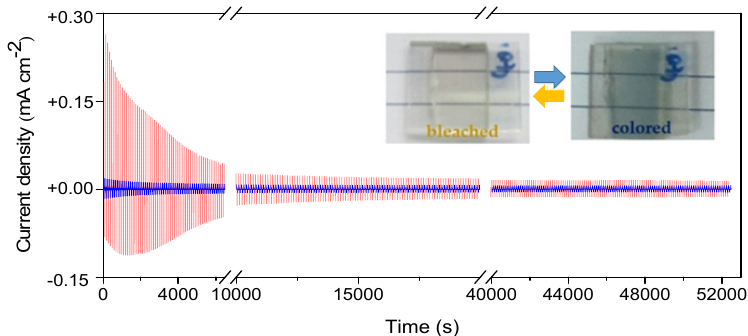
Figure 6. Current density as a function of time for the ECD@LiTrif-ErTrif 3 (blue line, voltage steps of ± 3.0 V) and ECD@LiTrif-[Er(tta) 3 (H 2 O) 2 ] (red line, voltage steps of ±3.5 V).